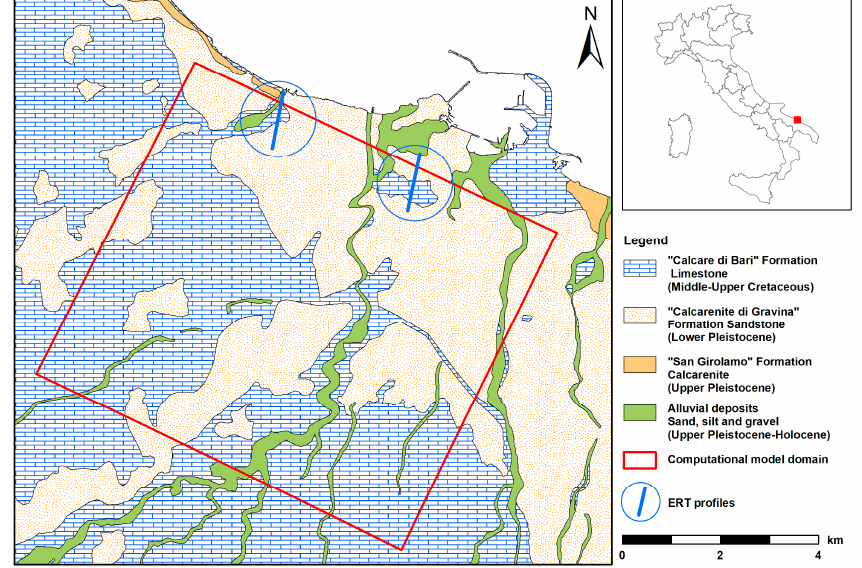
Figure 1. Bari site geological sketch and computational domain (red square) for groundwater flow and Ghyben-Herzberg simulations, and the positions of the electrical resistivity tomography (ERT) profiles of subsoil.